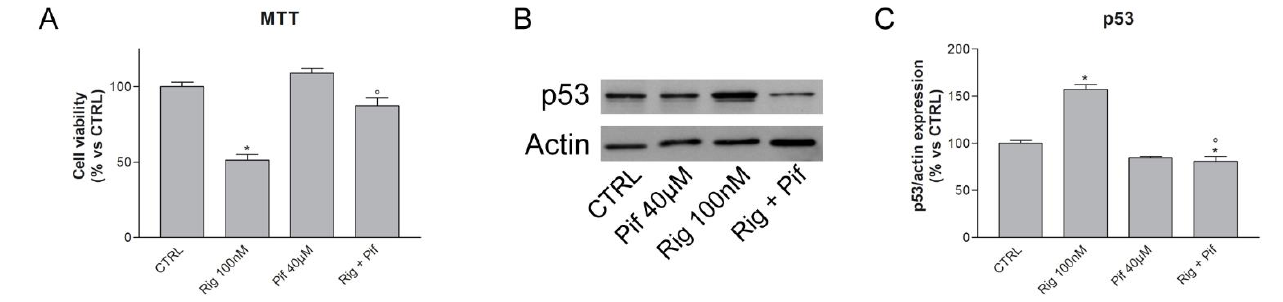
Figure 3. Evaluation of cancer cell viability and p53 expression after Rig and Pif treatment. ( A ) Cell viability of A549 cells was evaluated by MTT assay after 24 h of treatment, without treatments (CTRL), with Rig 100 nM, Pif 40 µM, or combination of Rig and Pif. ( B ) Representative images and ( C ) respective graph of p53 western blot of A549 cells treated for 24 h, without treatments (CTRL), with Rig 100 nM, Pif 40 µM, or combination of Rig and Pif. Graph represents the quantification of p53 expression, normalized to actin. * p < 0.05 vs. CTRL, ° p < 0.05 vs Rig 100 nM.